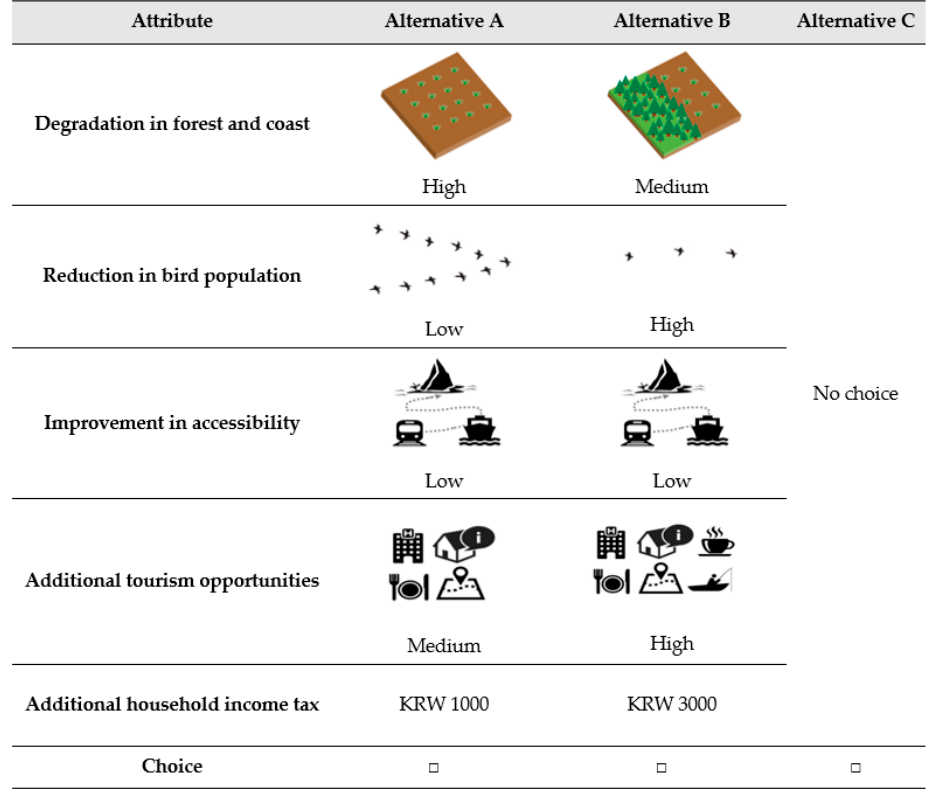
Figure 2. Example of a choice set.